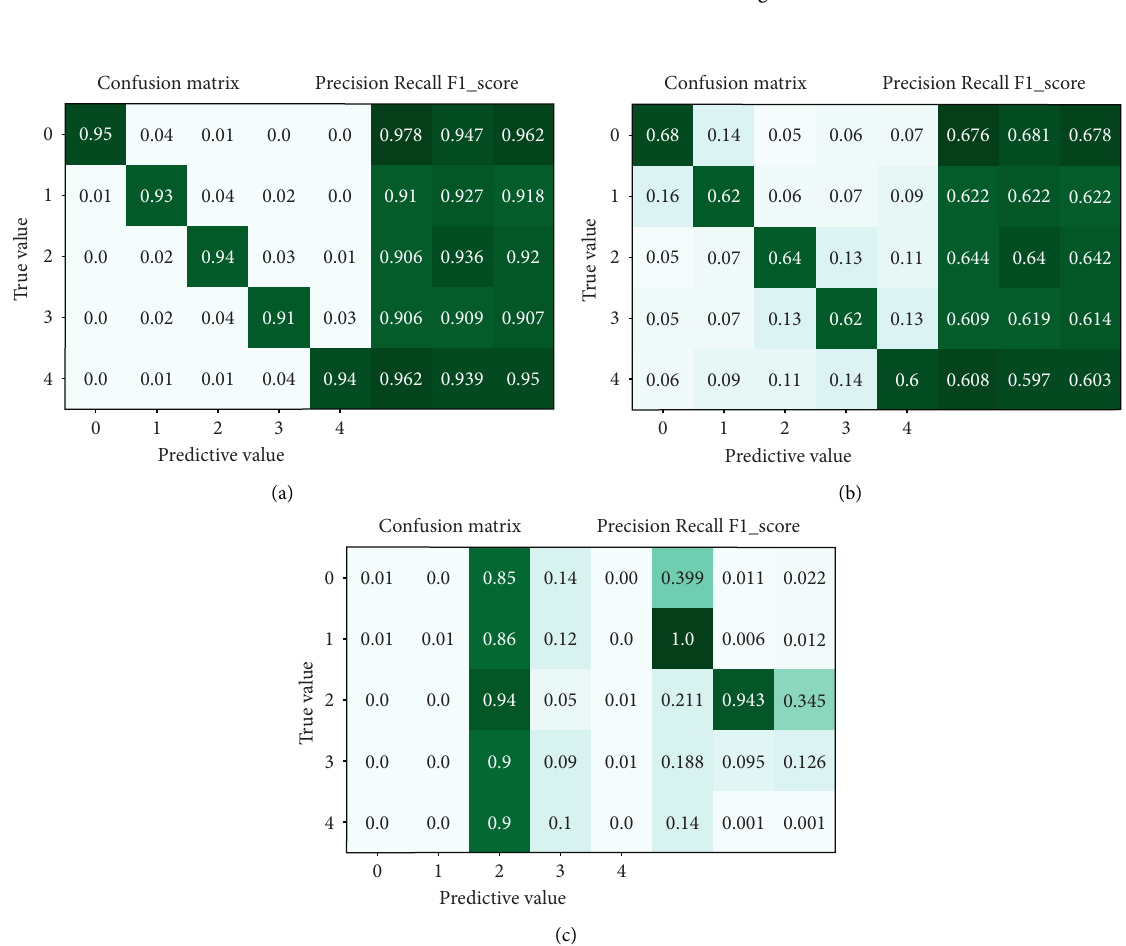
Figure 13: Workflow of RFs model training.